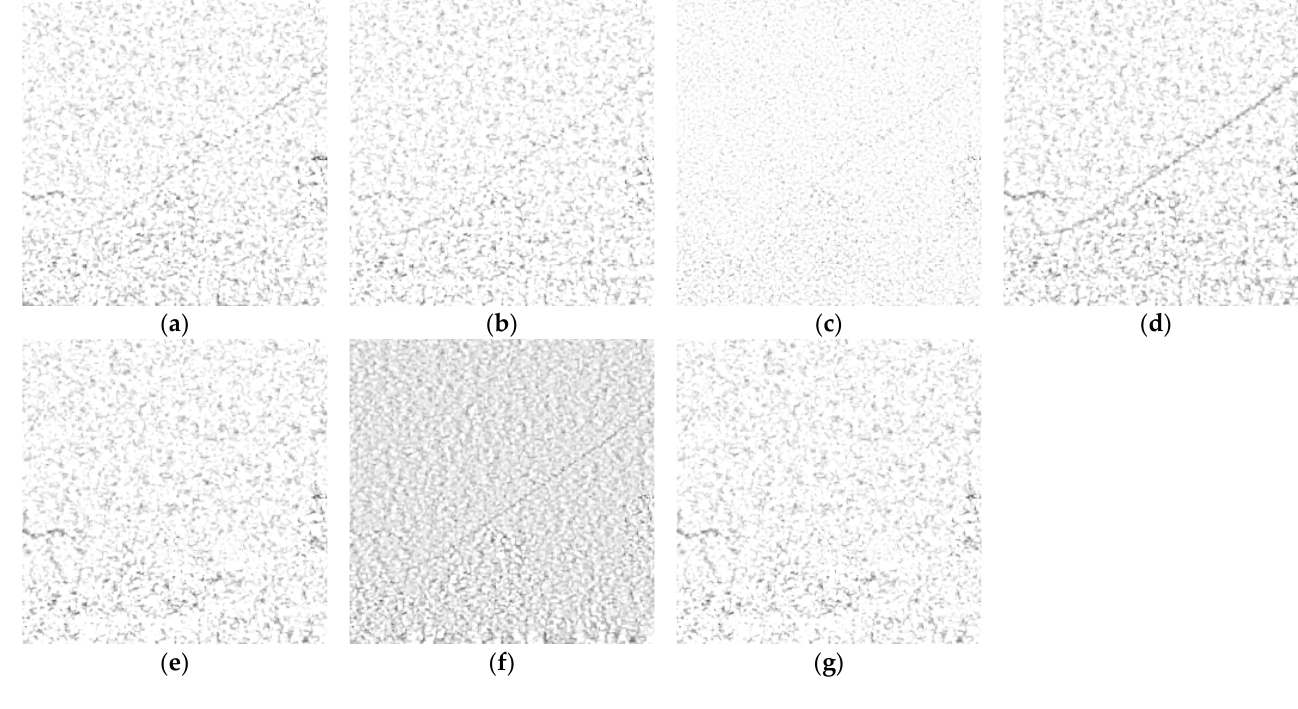
Figure 18. The corresponding ratio images for RS3. ( a ) W-C; ( b ) PPB; ( c ) SAR-BM3D; ( d ) H-WNNM; ( e ) GNLM; ( f ) FANS; ( g ) Proposed method.